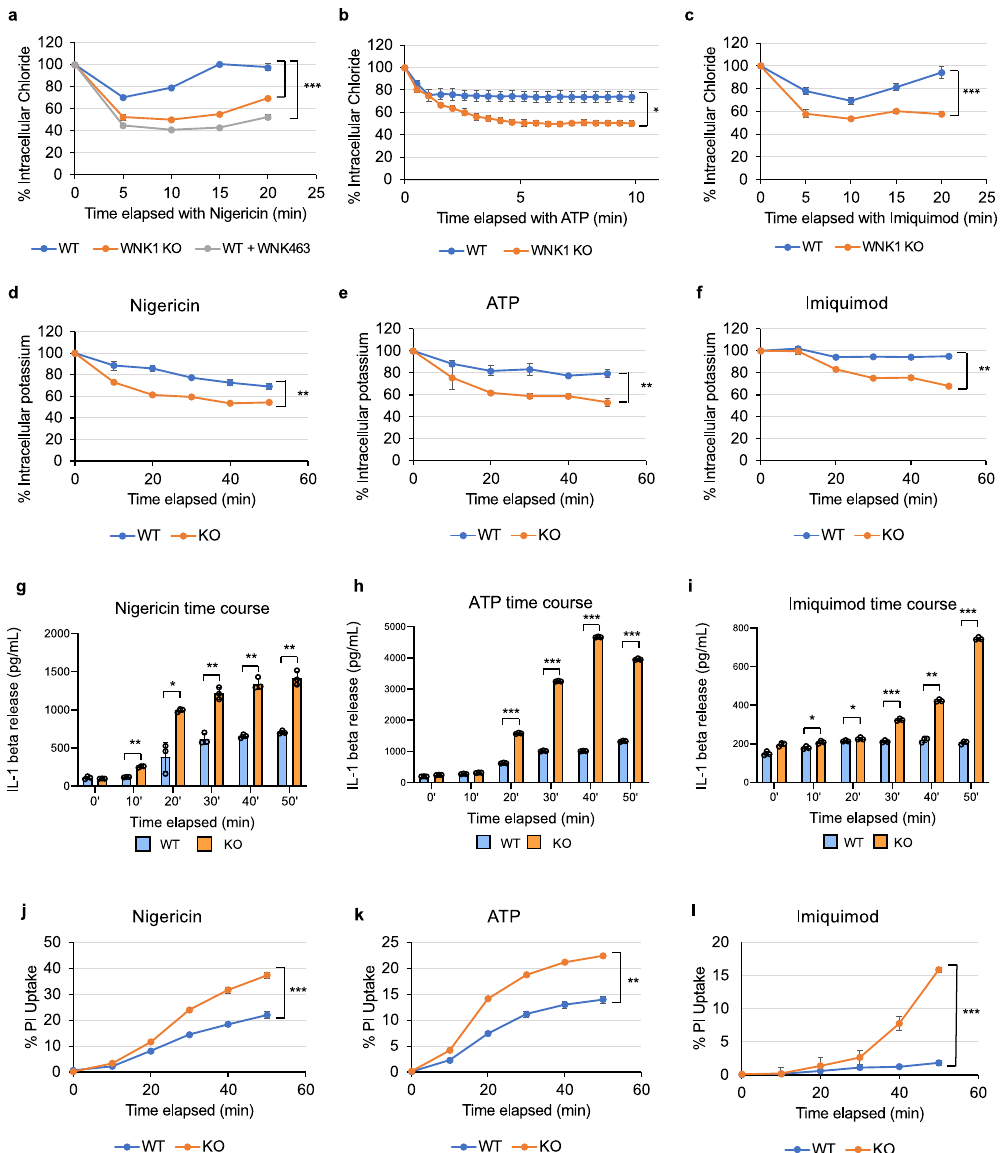
Fig. 6 WNK1 regulates intracellular Cl − in macrophages. Quanti fi cation of intracellular Cl − ( a – c ), K + ( d – f ), IL-1 β release ( g – i ) and propidium